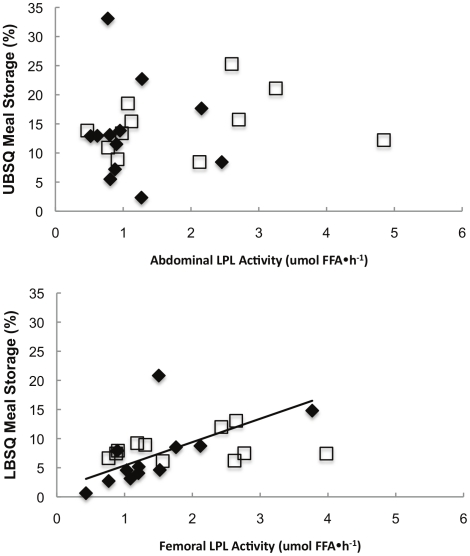
Regional LPL activity vs. regional meal fatty acid storage.Fed LPL activity in the abdominal (top panel) and femoral (lower panel) is plotted vs. the proportion of meal fatty acids stored in upper body subcutaneous (UBSQ) and lower body subctuaneous (LBSQ) adipose tissue. ♦represents T(+) men, □represents T(−) men, — represents a significant correlation in T(+) men.